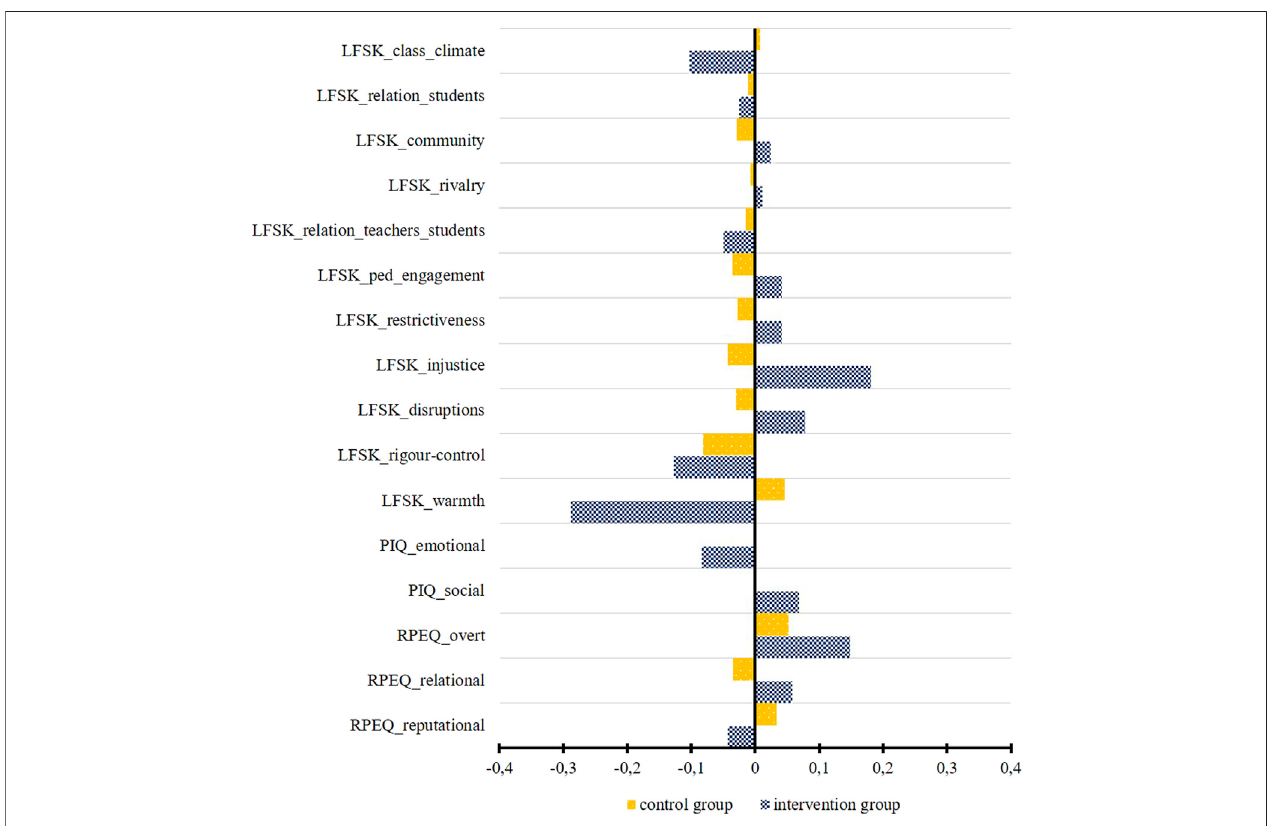
FIGURE 3 | Sensibility for